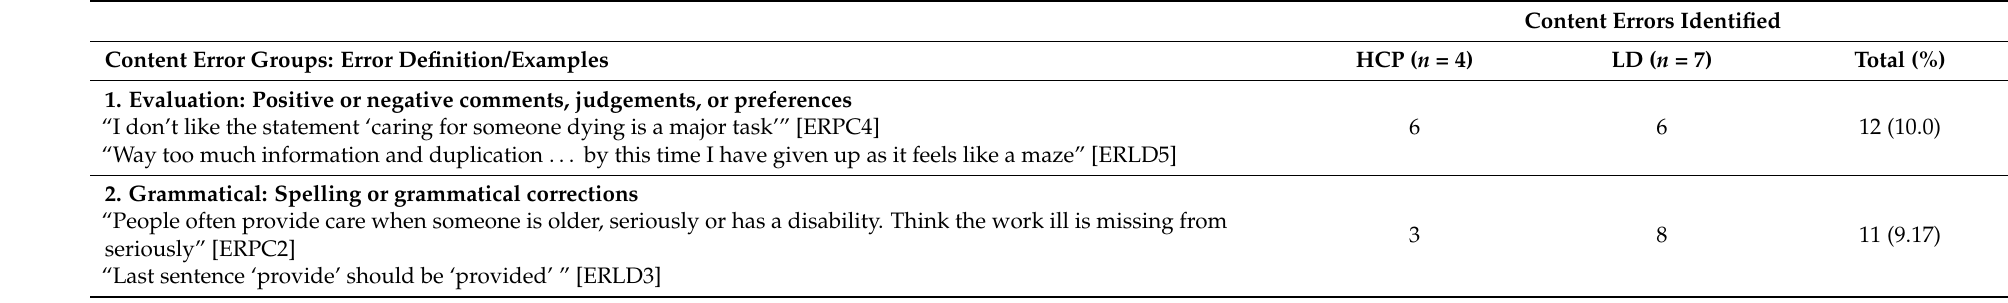
Table A2. Content-specific error examples and frequency of errors identified by expert review groups (HCP and